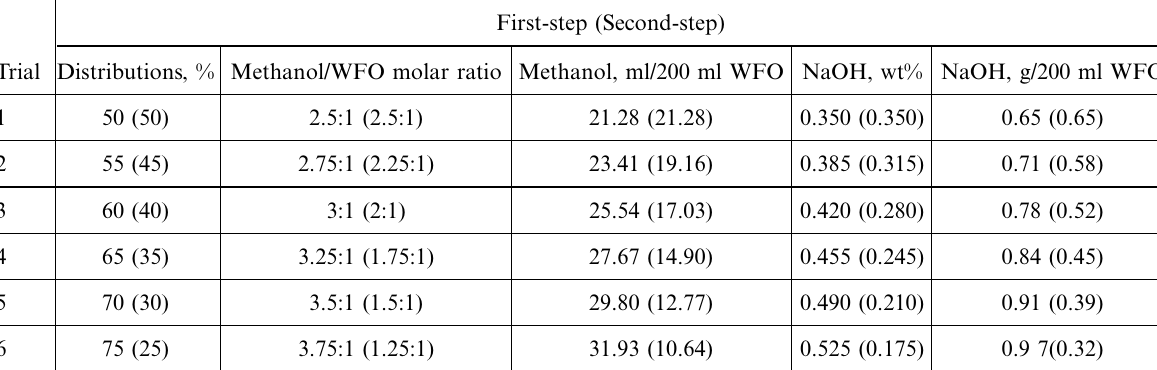
Table 2. Experimental schedule for conducting a two-step method First-step